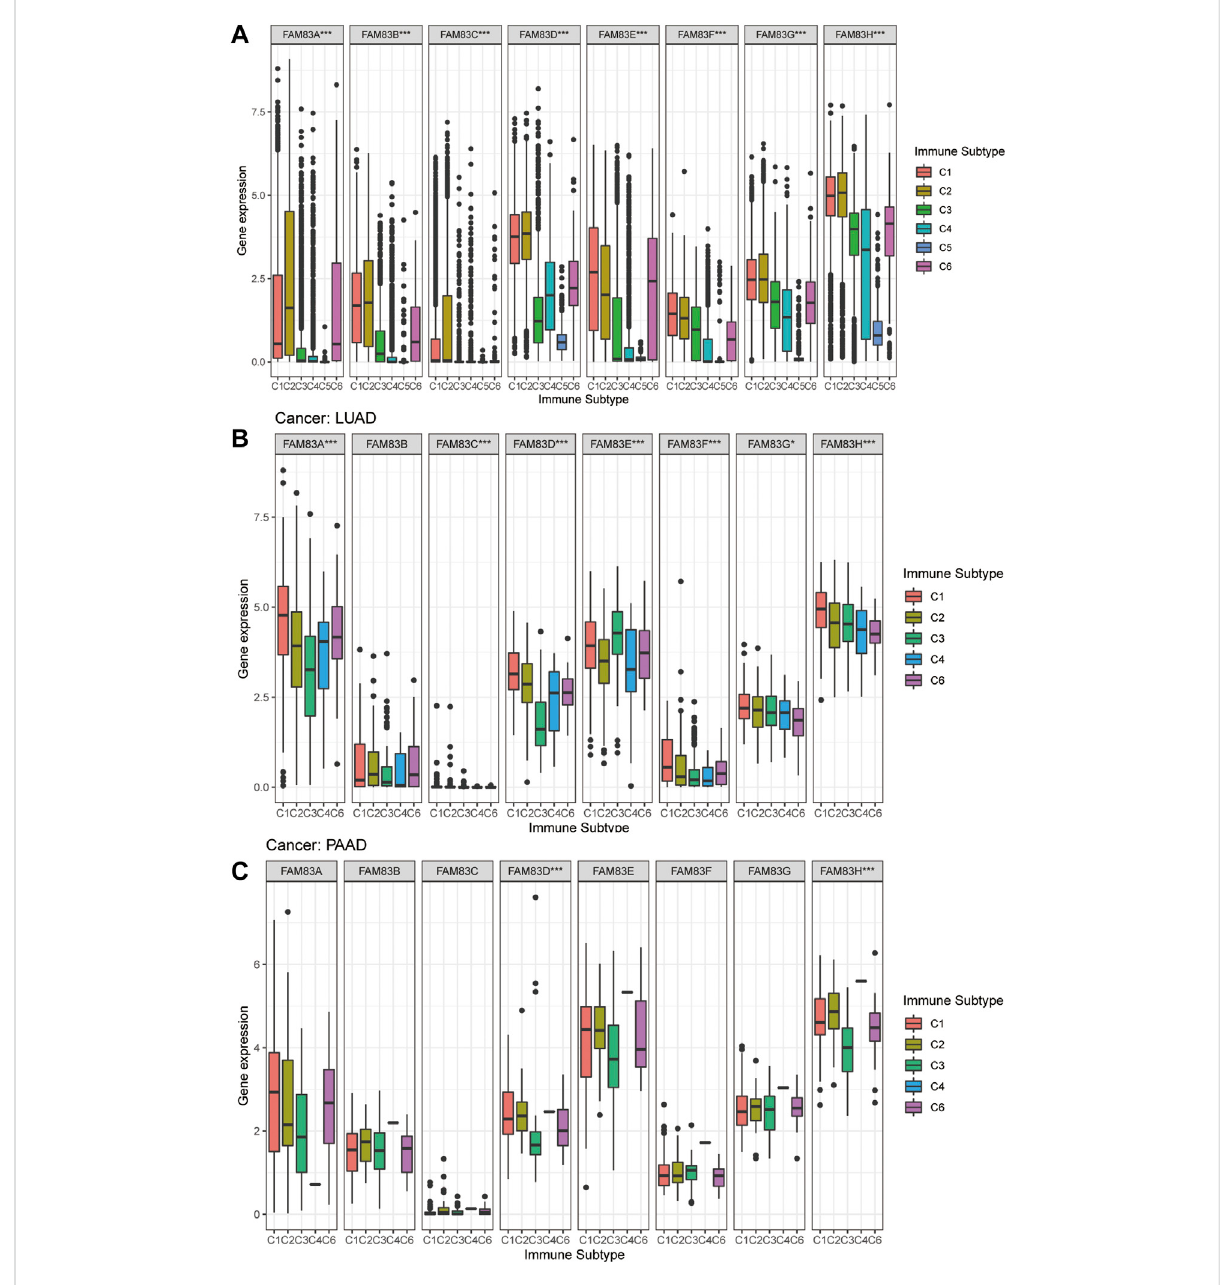
FIGURE 5 Expression analysis of FAM83 family genes in different immune subtypes. (A) Boxplots of the overall transcript levels of FAM83 family genes in the C1 – C6 immune subtypes across cancers. (B) LUAD. (C) PAAD. (*** p < 0.001; ** p < 0.01; * p <